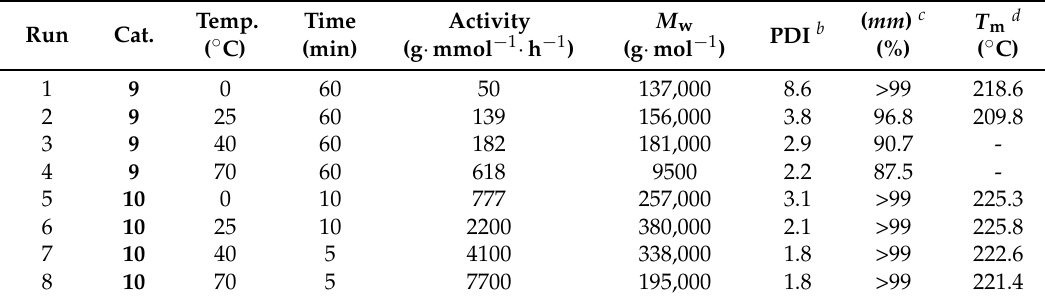
Table 1. Styrene polymerization with dibenzyl zirconium(IV) complexes 9 and 10 upon activation with dMAO. Run Cat.